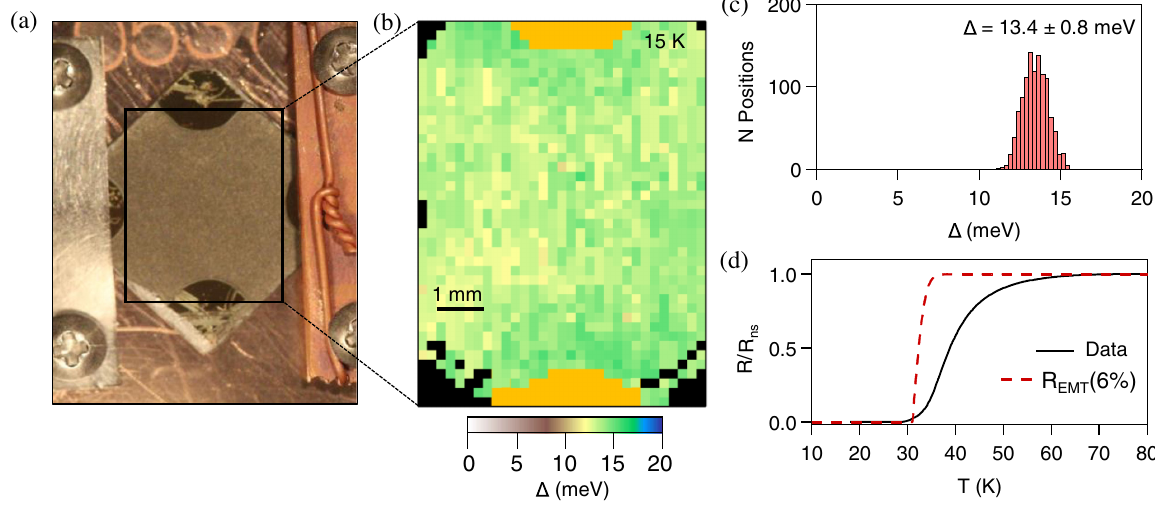
FIG. 6. Spatially resolved ARPES measurements of the superconducting gap. (a) Camera image of the single-layer FeSe = SrTiO 3 sample as mounted for beam line ARPES measurements. (b) Spatially resolved gap distribution measured across the sample surface of the region indicated in (a). The region probed is 8 mm × 6 mm. The gold-colored regions indicate areas with Au electrodes, and the black indicate regions where no FeSe signal is observed. (c) Histogram showing the statistical distribution of Δ e from the data in (b). The local gap values form a Gaussian-like distribution with a mean of 13.4 meV and a standard deviation of 0.8 meV. (d) R ð T Þ data normalized to the extrapolated normal state resistance (black line) compared to expected behavior for a percolative superconducting transition (dashed red line) assuming a local T c distribution matching the data in